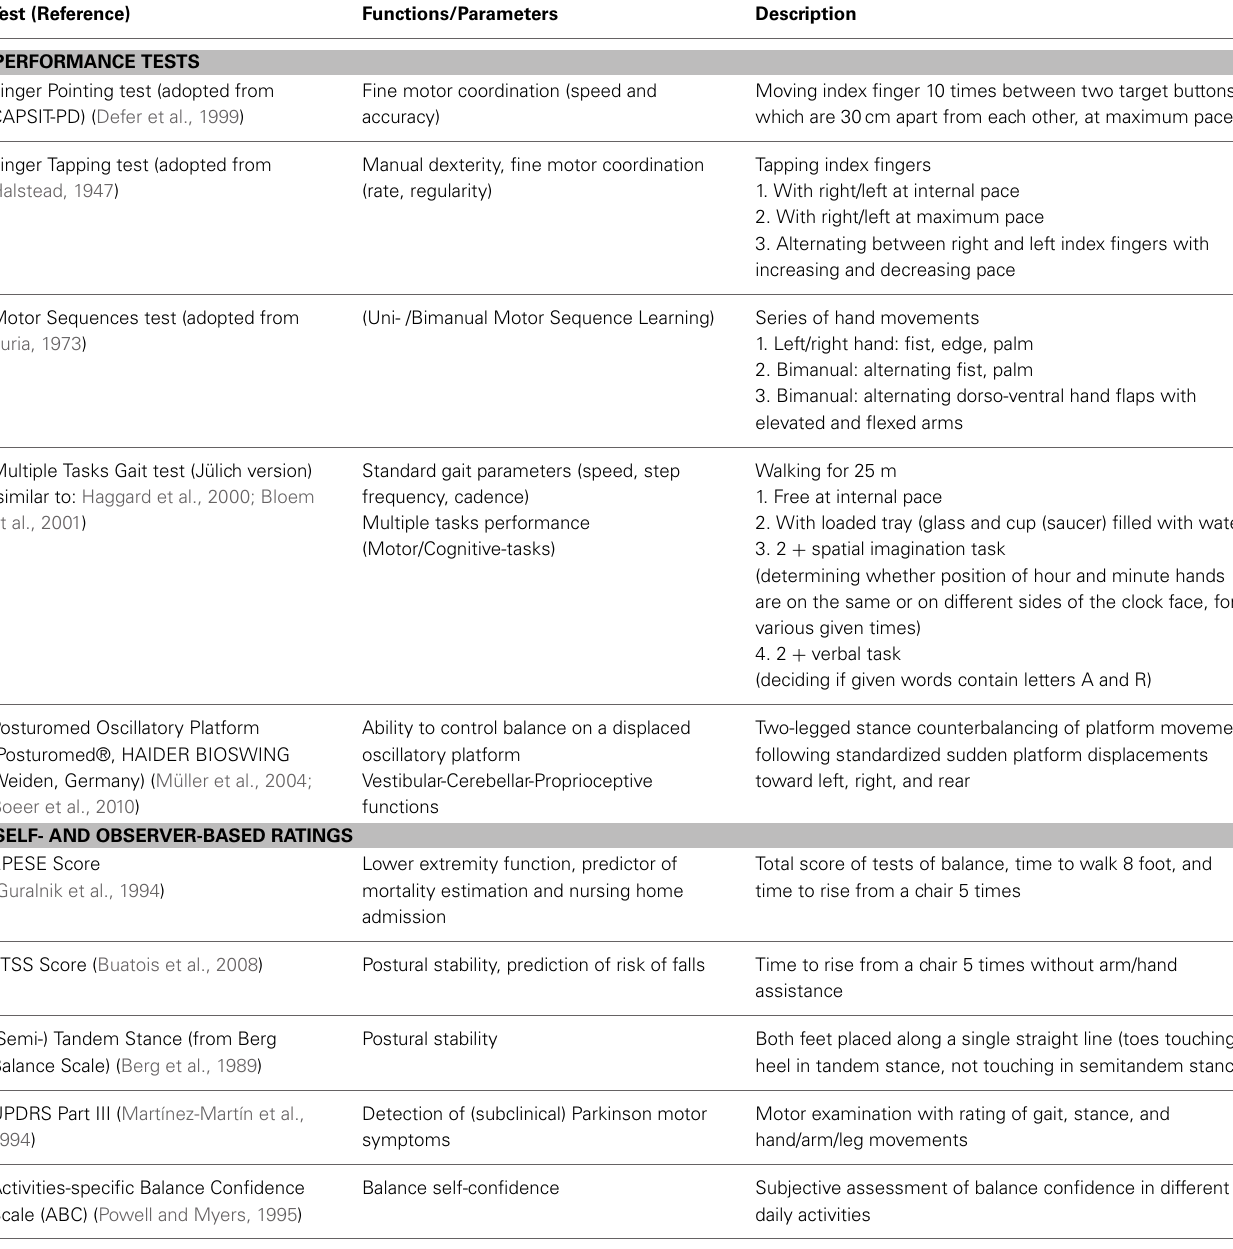
Table 4 | Motor assessment as administered in